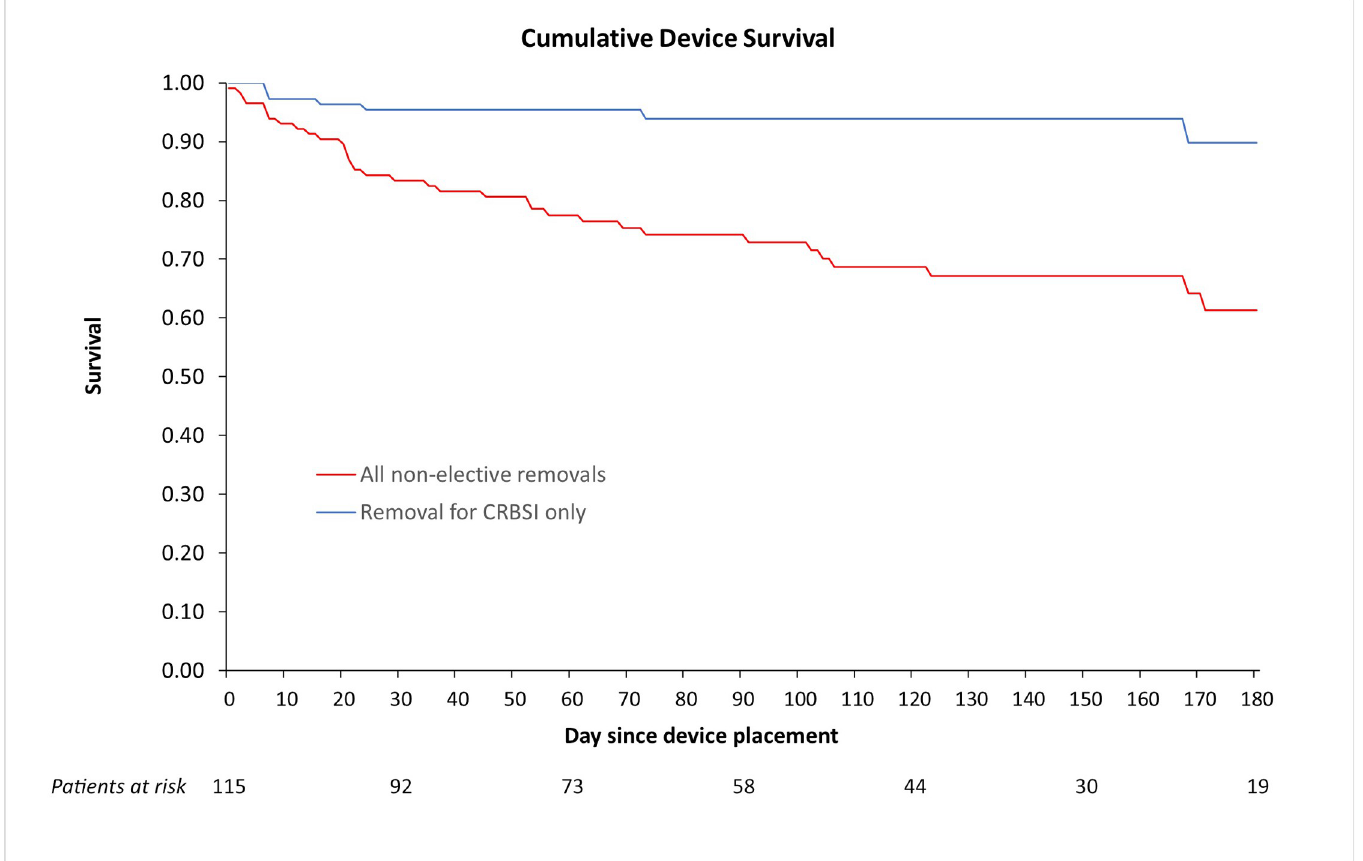
PLOS ONE | https://doi.org/10.1371/journal.pone.0223285 October 7,